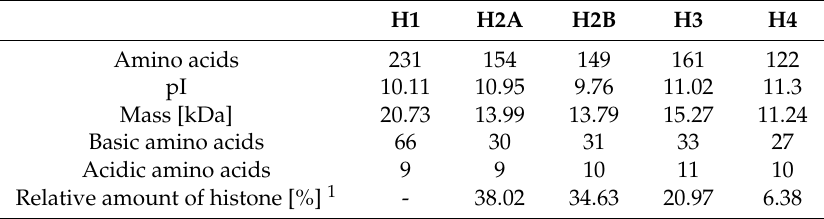
Table 1. Overview of the individual histone properties and the respective percentage of all histones in NET.